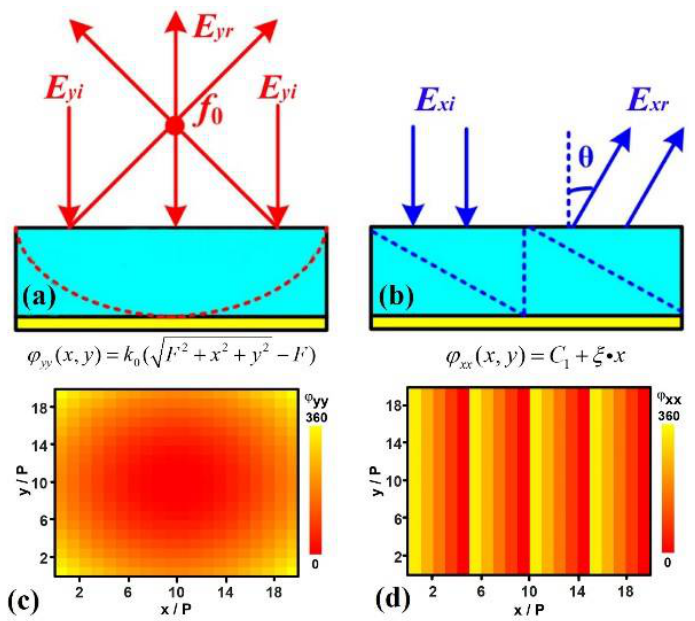
Figure 2. Schematics of a bi-functional metasurface (blue) with metal ground plane (yellow) which can achieve ( a ) focusing functionality for y -polarized incident light and ( b ) anomalous-reflection functionality for x -polarized incident light. The phase distributions of the metasurface are depicted in ( c ) for y -polarization excitation and in ( d ) for x -polarization excitation. Reproduced from [90] with permission.